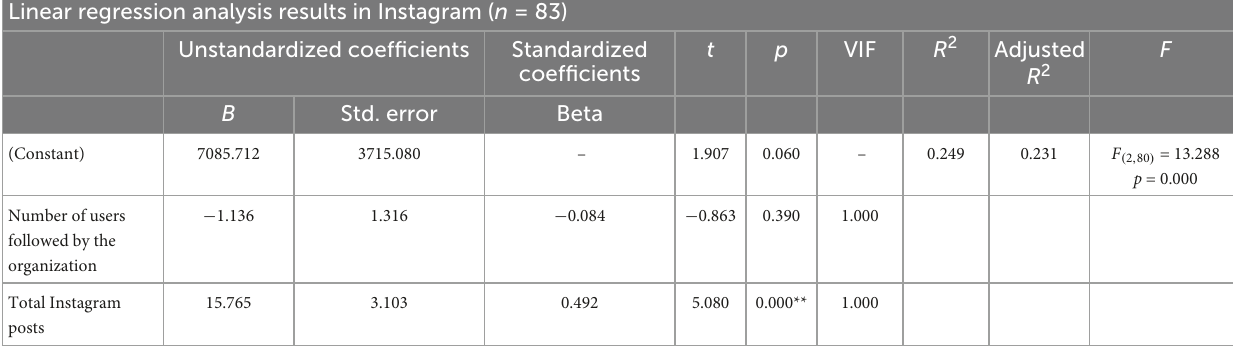
TABLE 7 Linear regression analysis of the effect of total Instagram posts and the number of users followed by the organization on the number of Instagram followers. Linear regression analysis results in Instagram ( n =